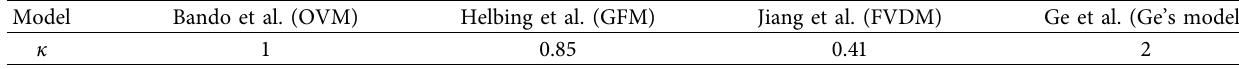
Table 1: Driver’s sensitivity in different